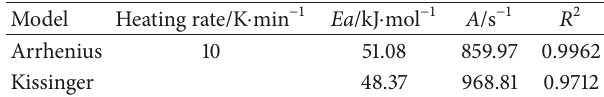
proceeds rapidly with increasing temperature until about 573 K.